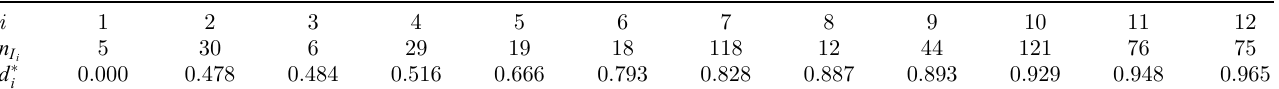
Table 2. Description of the k I = 12 irregular clusters I i , i = 1, ... , 12. n I reported from left to right in increasing order. Using the process ( Z i,t ) t – see equation